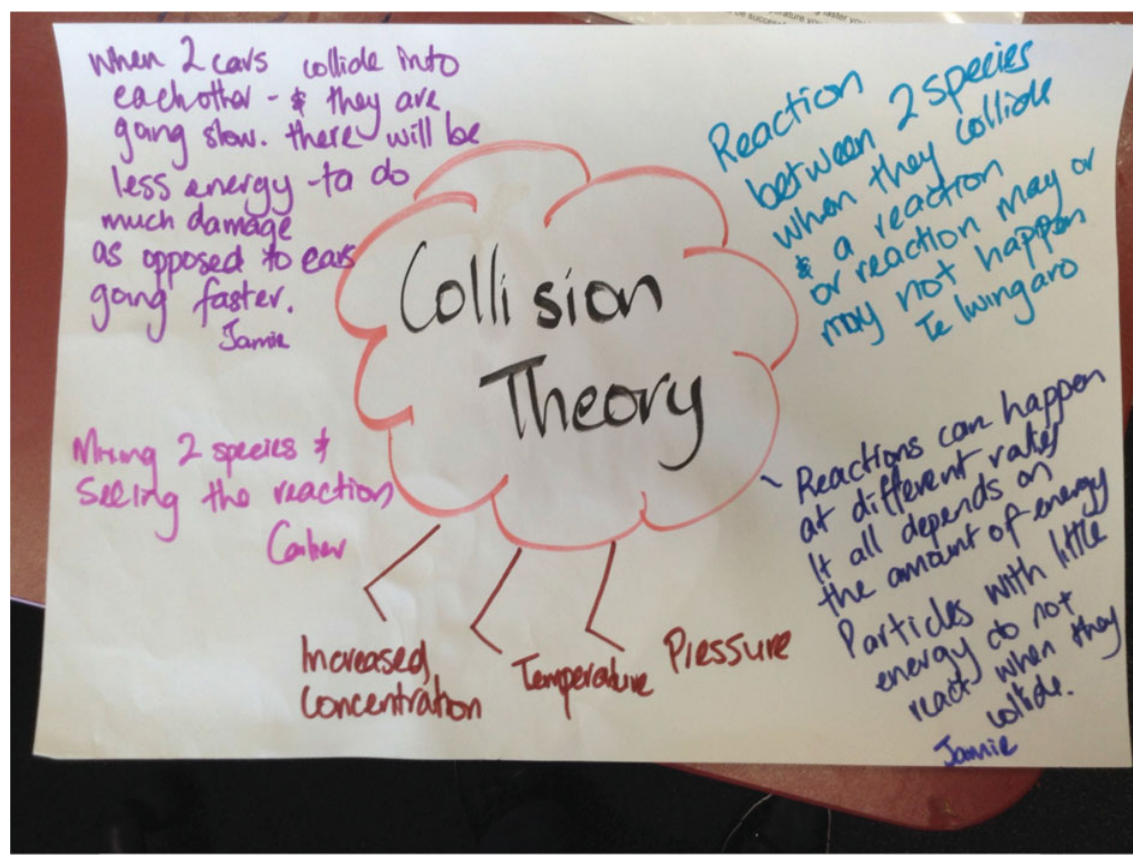
Mind map about collision theory developed together by the students and the